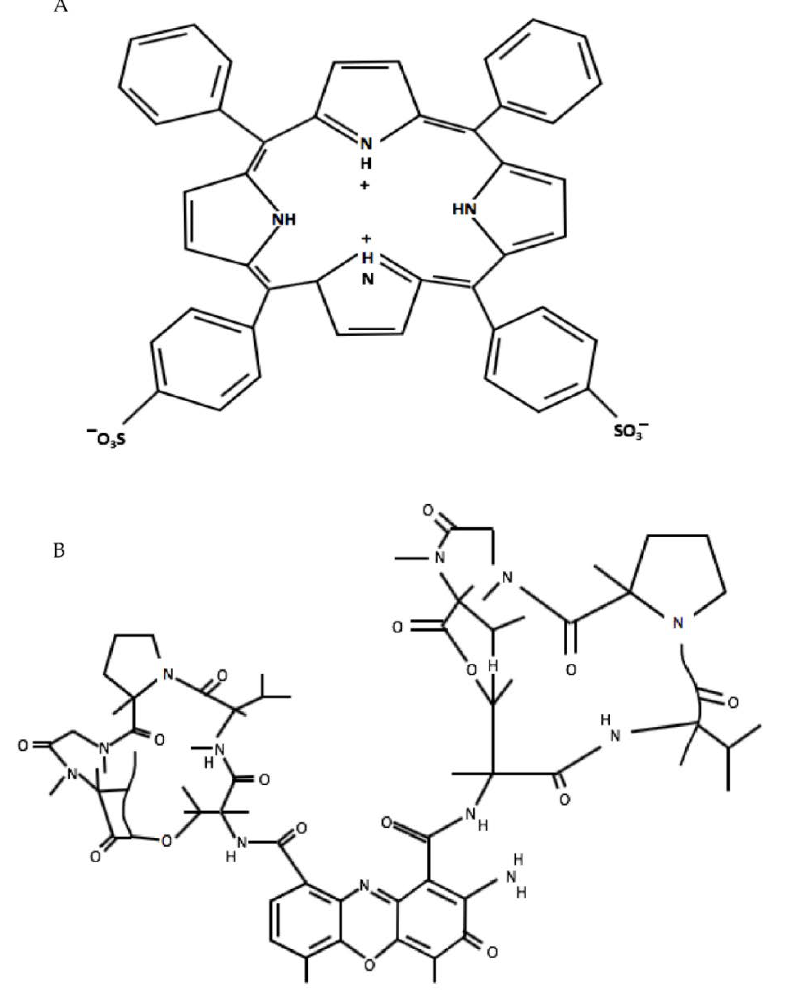
Figure 1. Structures of meso -tetraphenylporphine disulfonate (TPPS 2a ) ( A ) and dactinomycin (actinomycin D) ( B